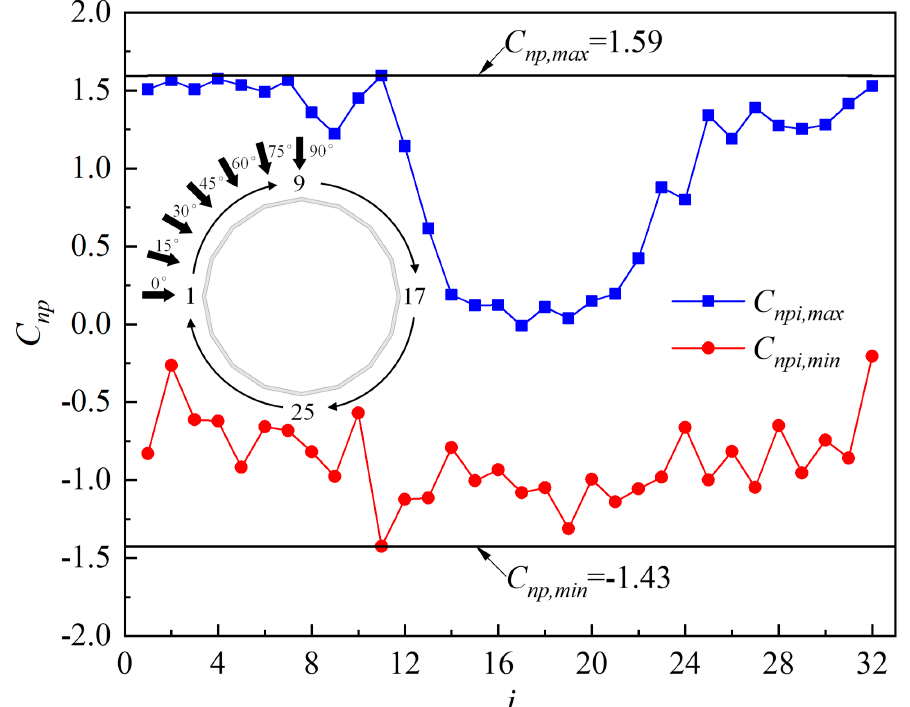
Figure 33. Envelope of the extreme net wind pressure coefficients at measuring points on the outer surface of the grid structure.